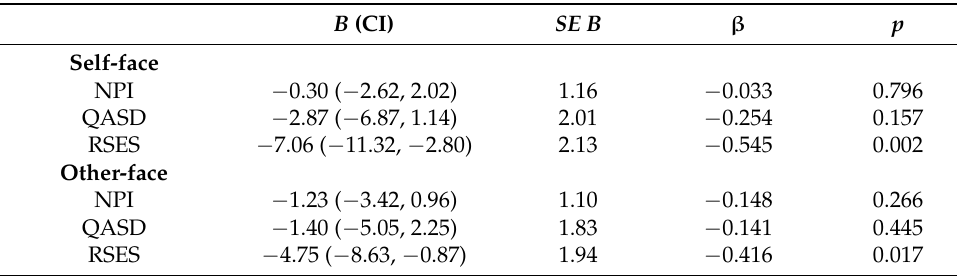
Table 2. Regression analyses for gaze